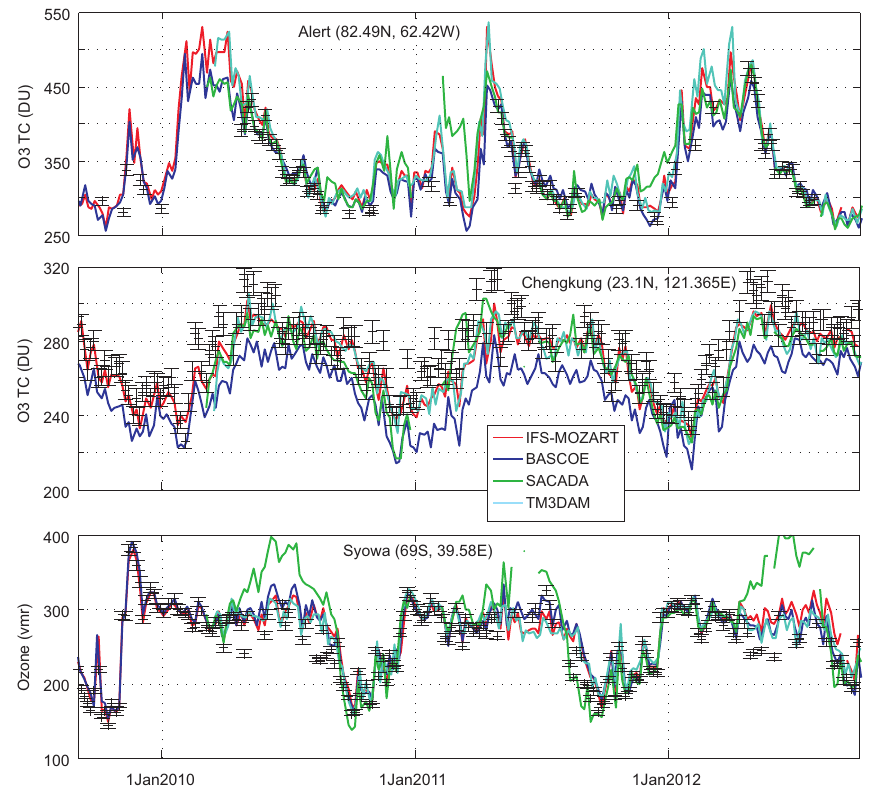
Figure 2. Comparison between the TOC time series (5-day moving average) of the four analyses of the MACC stratospheric ozone service (IFS-MOZART in red, BASCOE in blue, SACADA in green, and TM3DAM in cyan) interpolated to a high northern latitude station (Alert, 82.49 ◦ N, 62.42 ◦ W), a tropical station (Chengkung, 23.1 ◦ N, 121.365 ◦ E) and a southern latitude station (Syowa, 69 ◦ S, 39.58 ◦ E), for the period from September 2009 to September 2012. Black symbols are 5-day moving averages of Brewer (for Alert and Chengkung) and Dobson (for Syowa) observations from the WOUDC network. In order to indicate the observational uncertainty, the height of each symbol is set to 4% of the observed